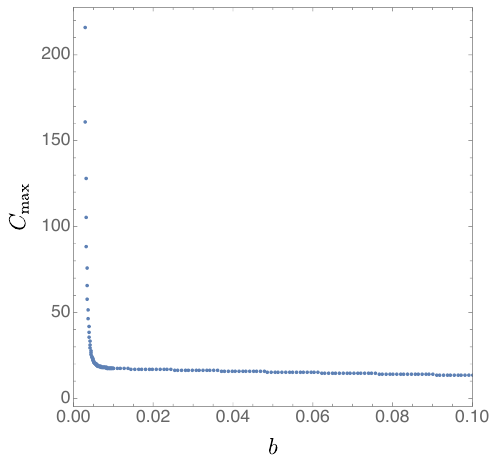
Figure 8 . C max as a function of b for a = 1, n = 2 and pro(cid:12)le (3.27): the blow up as b ! 0 suggests that the solution stops existing precisely when an ergoregion (cid:12)rst